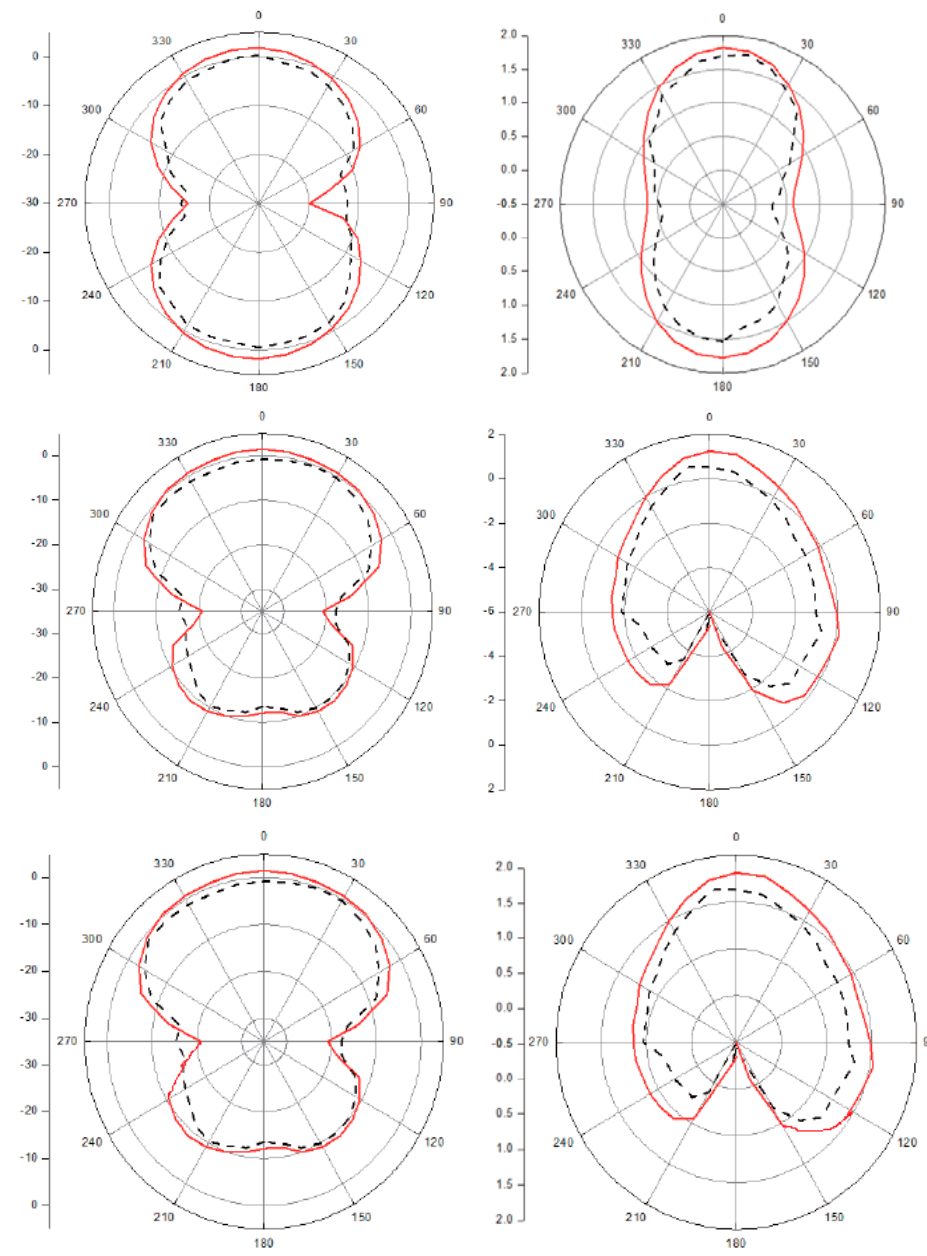
Figure 11. Radiation pattern measured (dotted-line) and simulated (straight-line) at frequency 9.5 GHz (E-plane graphics on the left side and H-plane graphics on the right side).